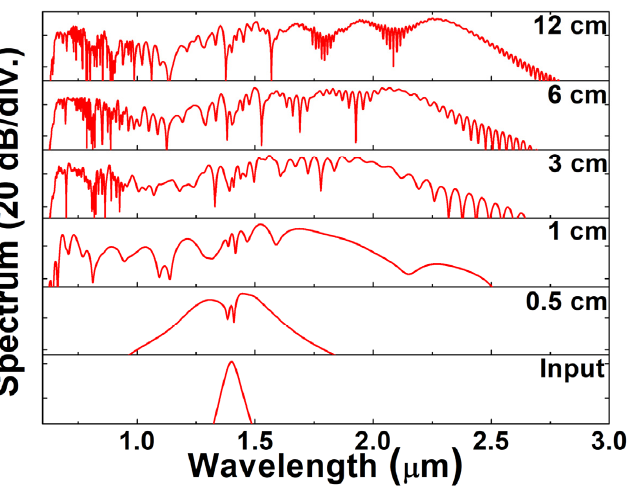
Figure 7. Broadening of the output spectra obtained at different lengths of the designed Ge-doped silica RCF.